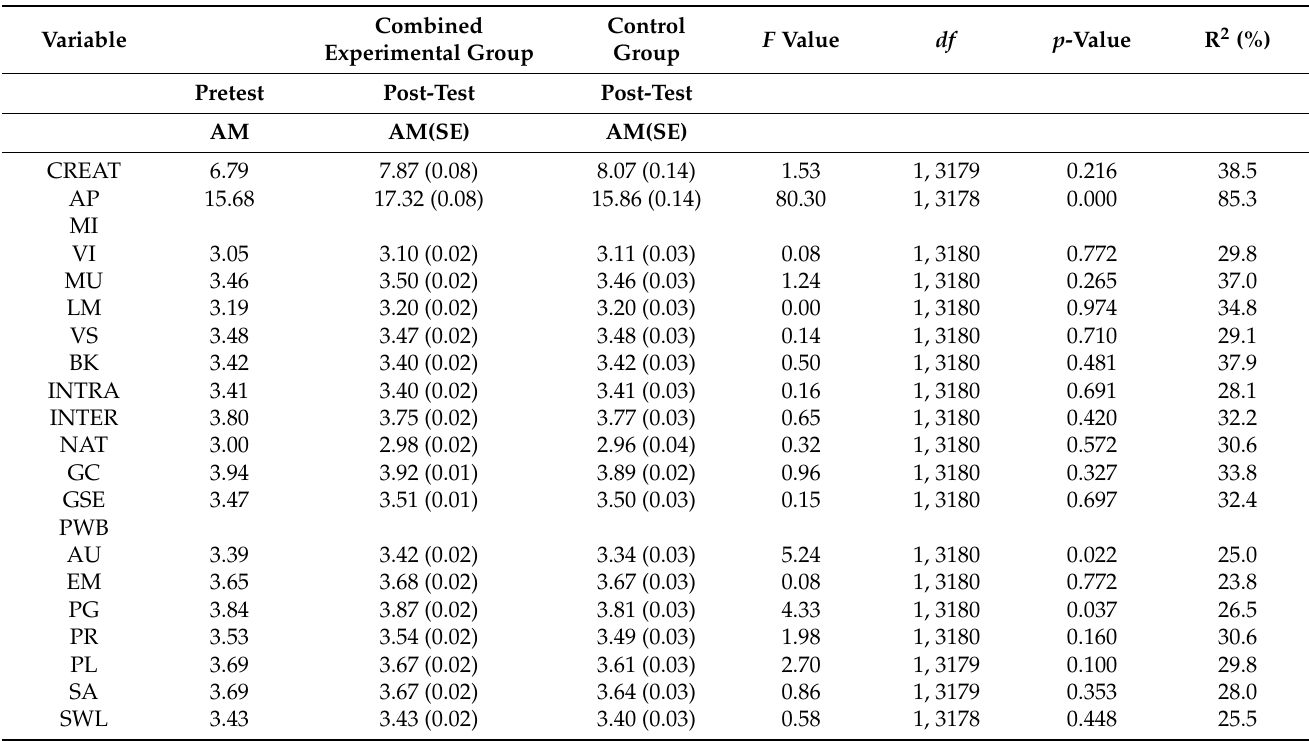
Table 5. Results of one-way ANCOVA on all outcome variables of students in the combined experi- mental groups and the control